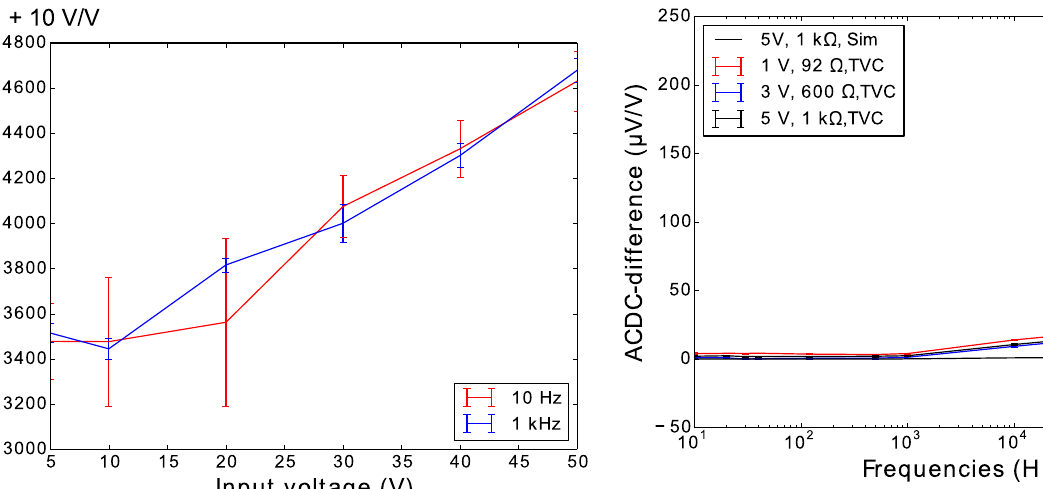
Fig. 6. Resulting absolute ac voltage division ratio of the divider and buffer combination. The 10 Hz sweep is in red and the 1 kHz sweep is in blue.